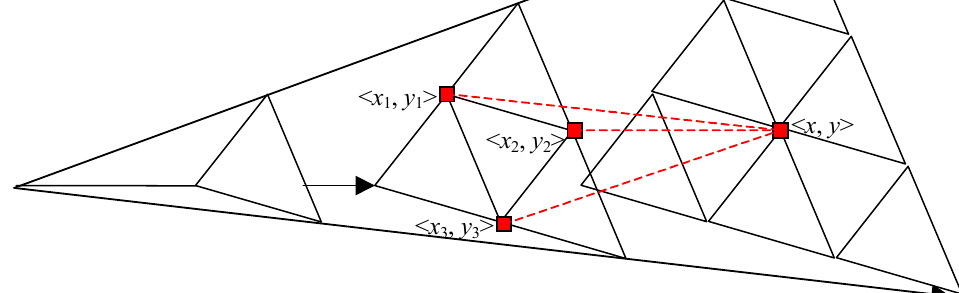
Figure A1. A two-asset Chen–Chung–Yang Model.